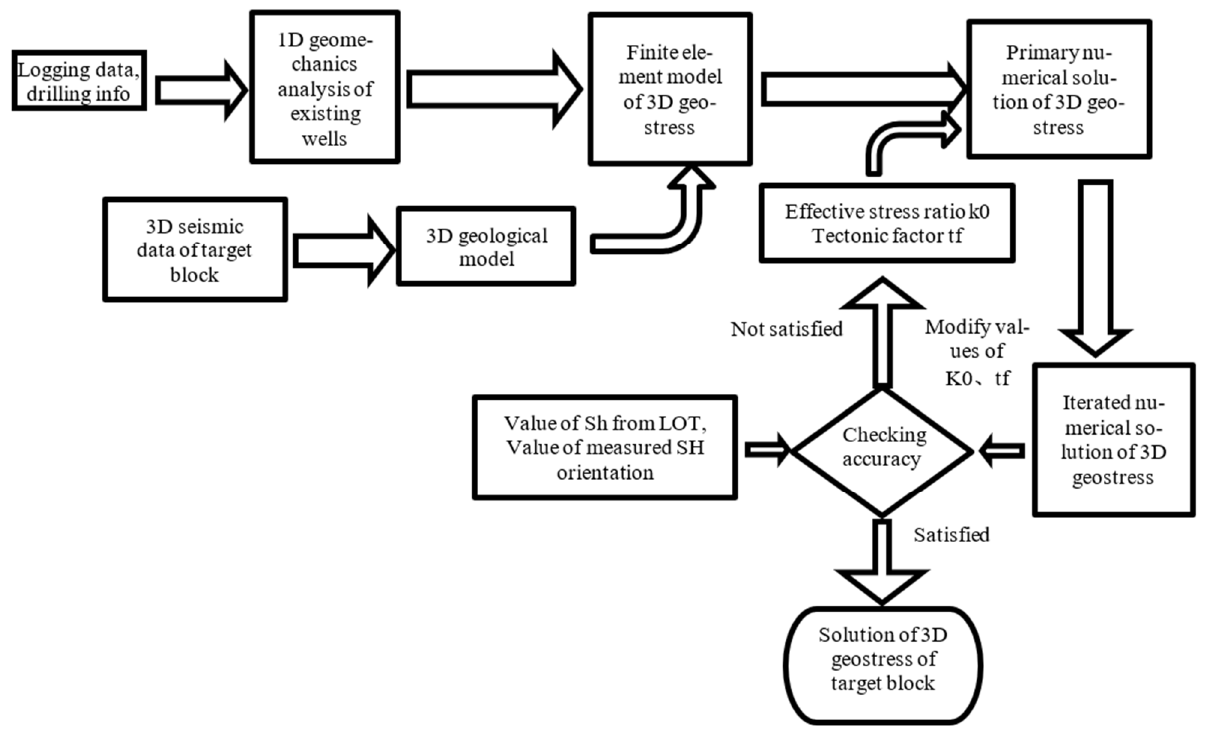
Figure 4. Workflow for calculation of 3D geostress.